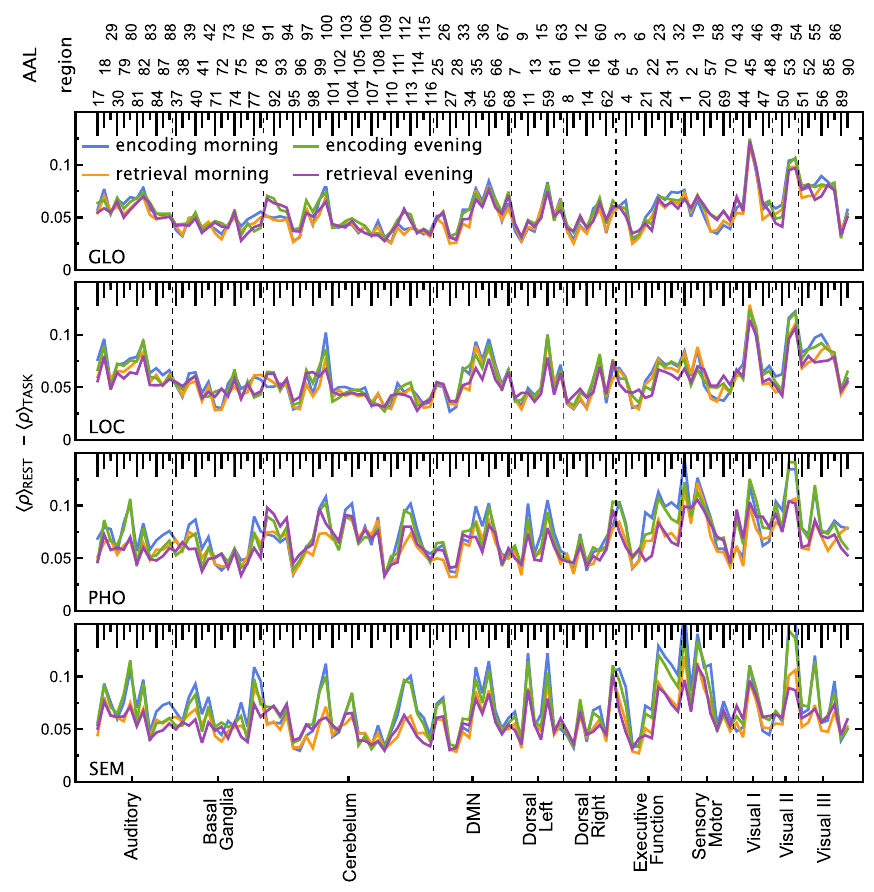
1, s 10 ) ρ( q (group mean for each ROI) for tasks GLO, LOC, � = = �